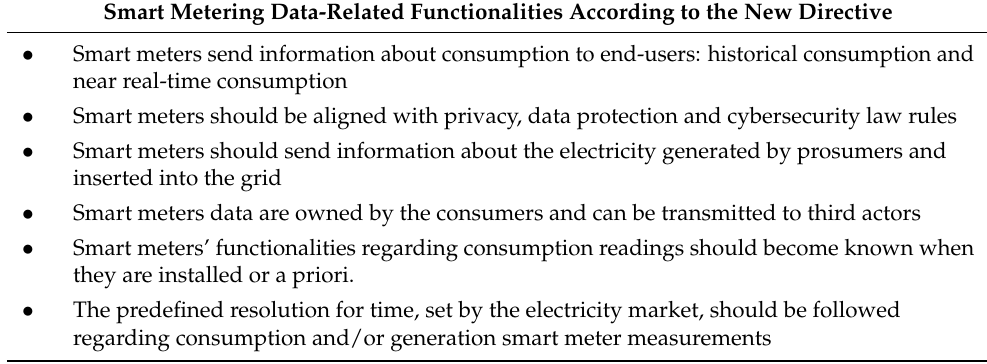
Table 4. Summary of main provisions on SM systems introduced by the Clean Energy